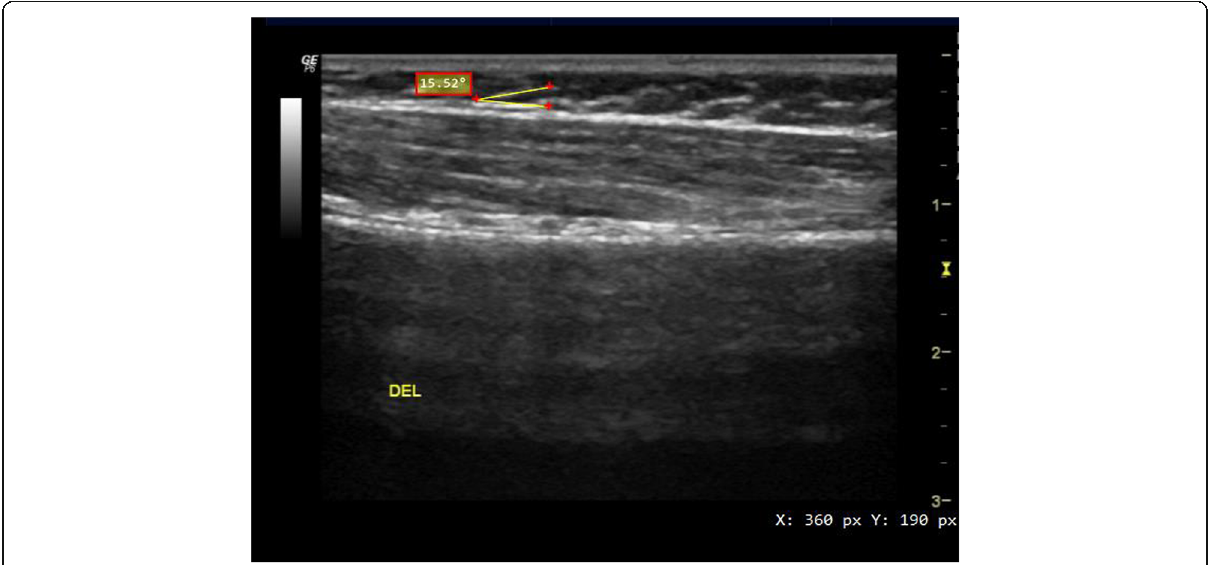
Fig. 1 Measurement of pennation angle of the anterior deltoid muscle by